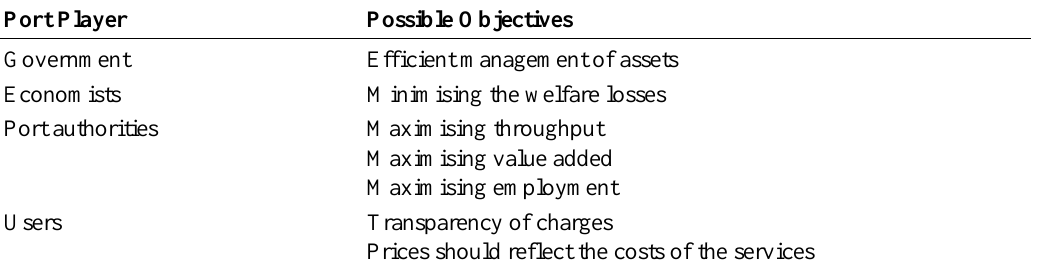
Table 1. Port players and their possible objectives Port Player Possible Objectives